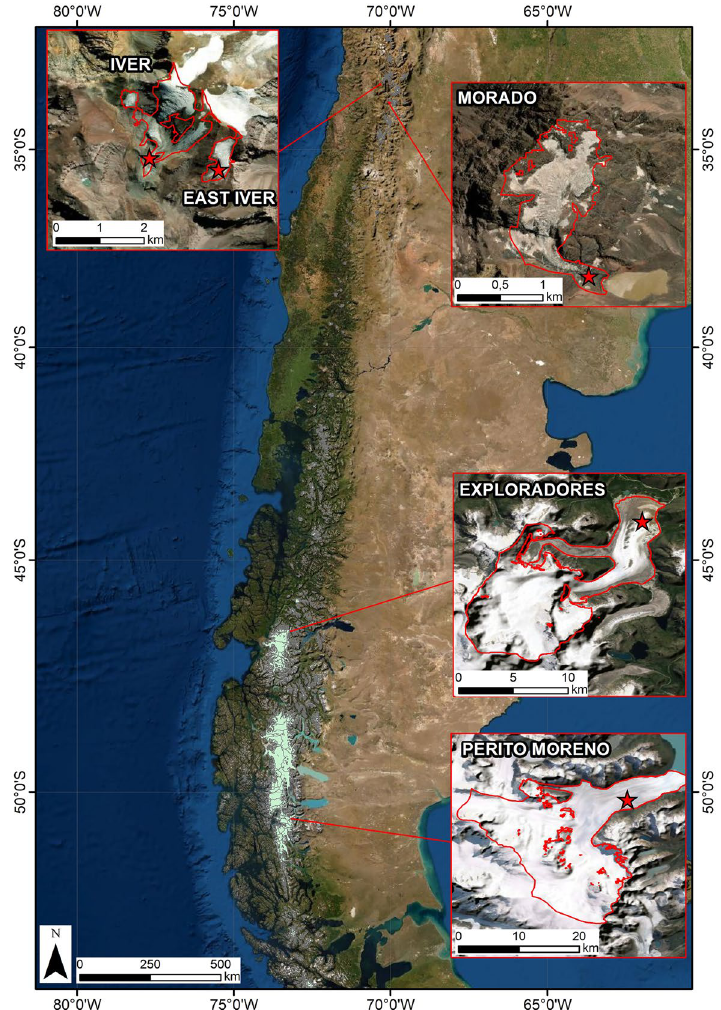
Figure 1. Location Map of Andean glaciers located in Chile and Argentina analysed in this report (ArcGIS Online map hosted by Esri). Glacier limits and morphological parameters were obtained from the Randolph Glacier Inventory 6.0 (RGI Consortium 2017). Stars indicate the position of the sampling